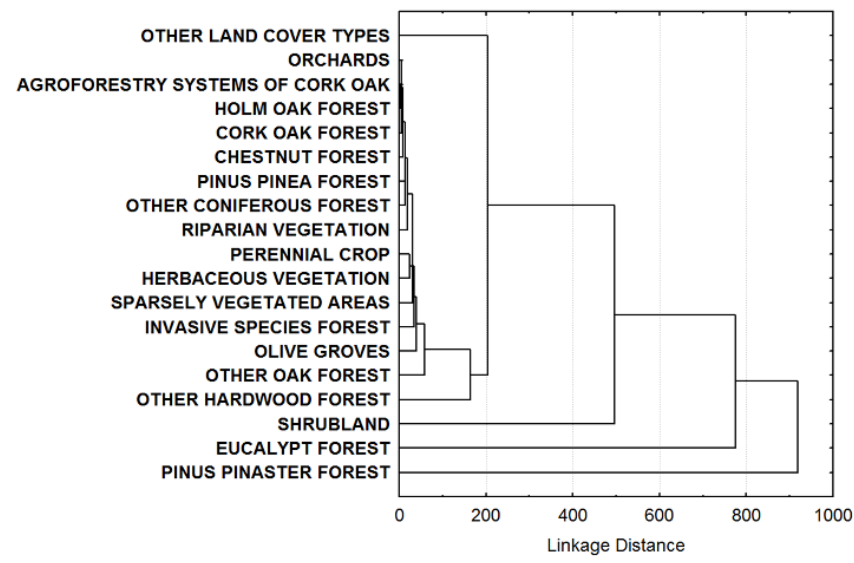
Figure 8. Euclidean distances (single linkage) of dNBR P6 of LUC classes.